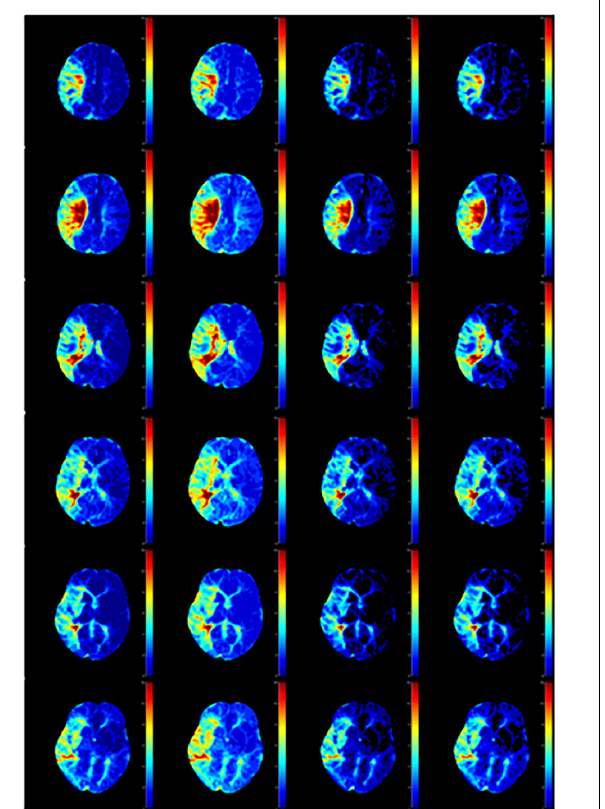
FIGURE 7 | rCBF calculated by AIF from (A) Manual, (B) MS3DCNN, (C) fuzzy c-means, and (D) U-Net3D + fuzzy c-means in each column from left to right.